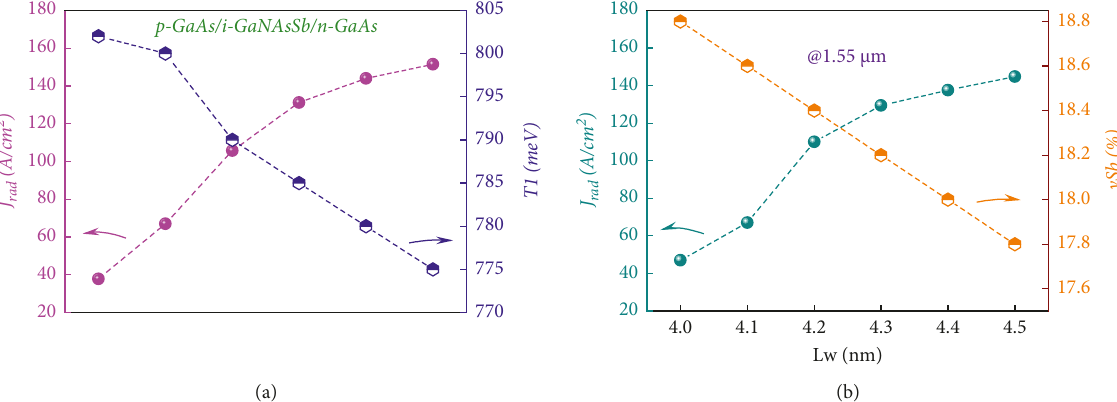
Figure 5: (a) Variation of radiative current density and fundamental energy transition as function of well width. (b) The adjusted value of Sb composition and radiative current density at 1.55 μ m.